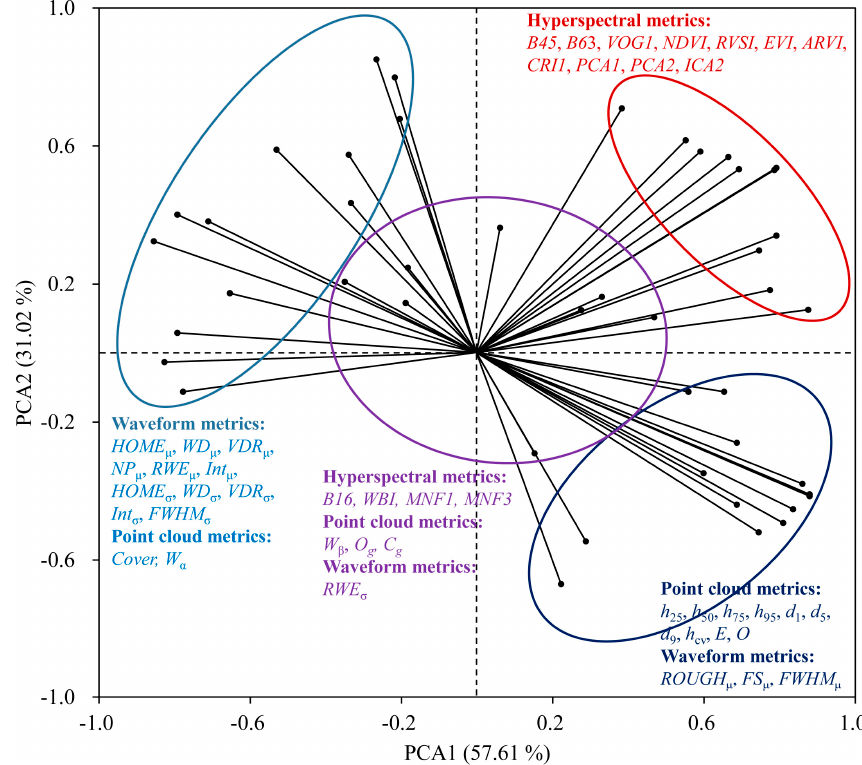
Figure 5. Projection of the first two PCA scores from the selected point cloud, waveform and hyperspectral metrics. The color ellipsoids represent the visual metrics clusters. See Tables 3 and 4 for the description of the metrics.